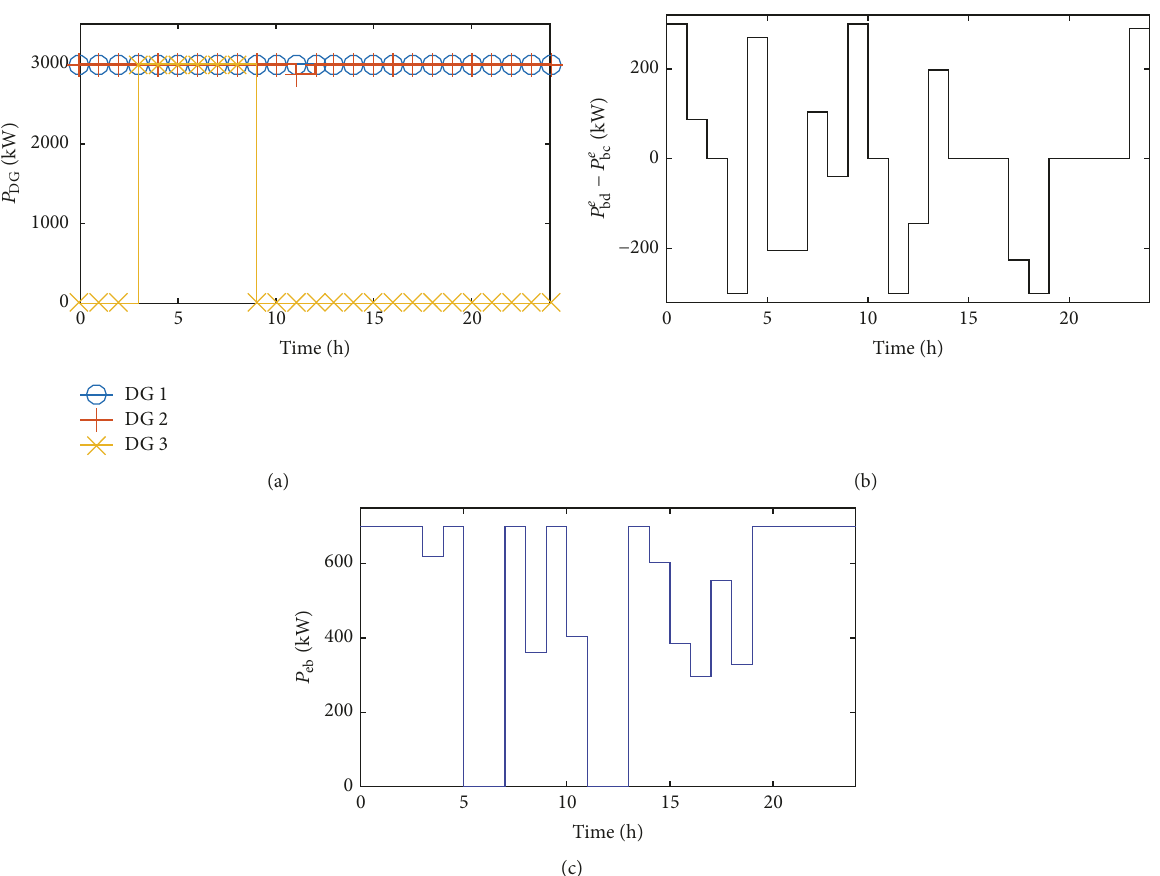
Figure 6: Scenario 4: (a) dispatch values of DG 1, DG 2, and DG 3, (b) BESS charge and discharge profiles, and (c) 𝑃 eb